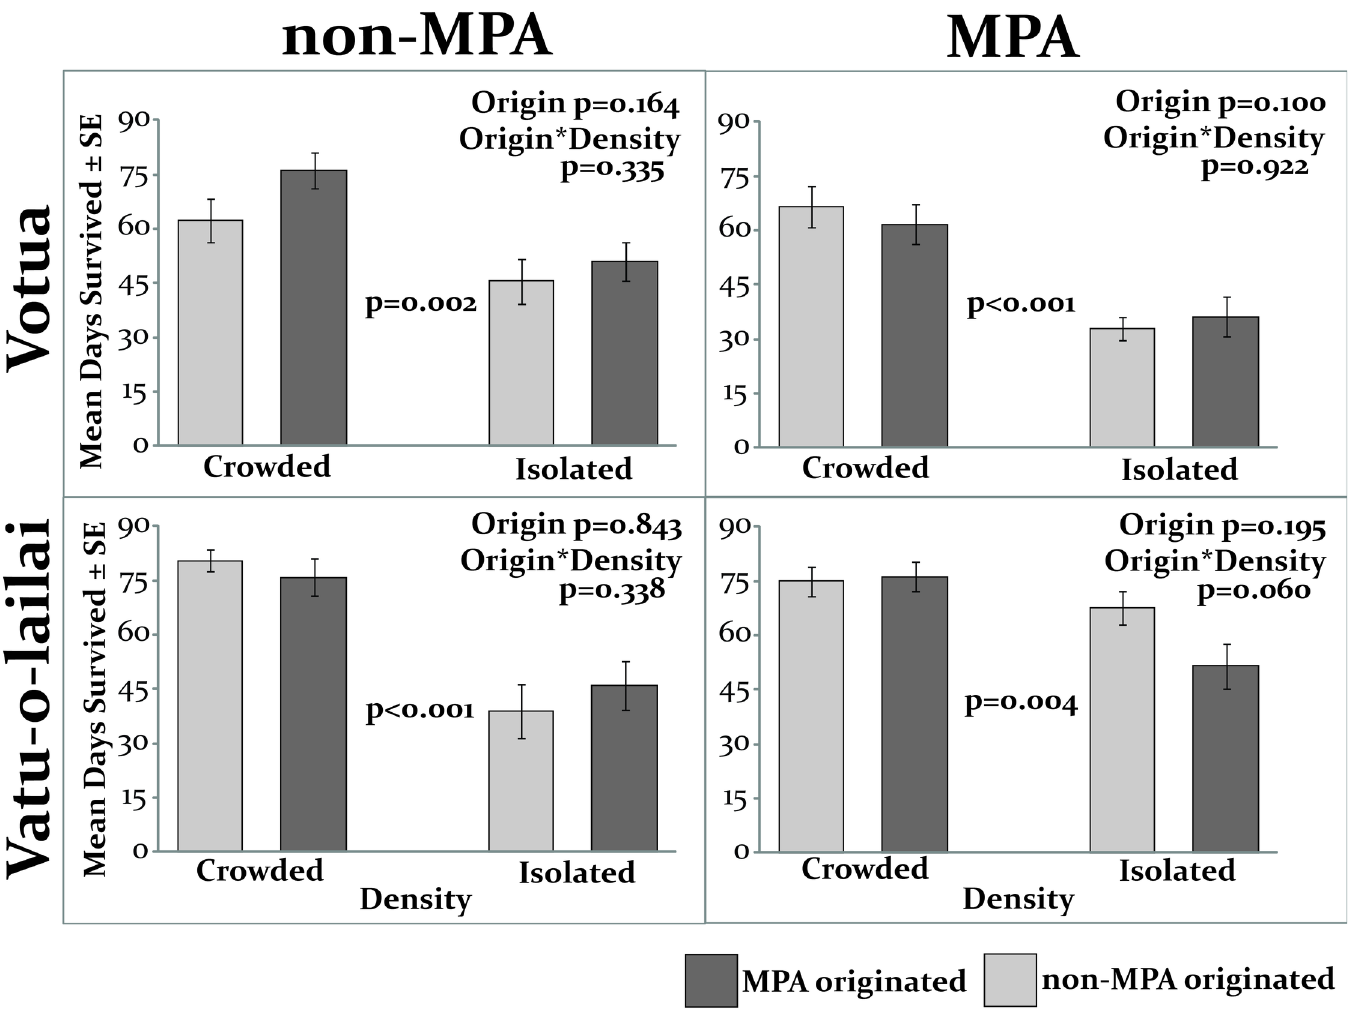
Fig 5. Survival of recruit-sized ramets growing in crowded or isolated densities in the MPA and non-MPA of both villages (N = 15). Initial height was subtracted from final height for all ramets, meaning those that died were included as negative values; statistical analyses were by Permutation